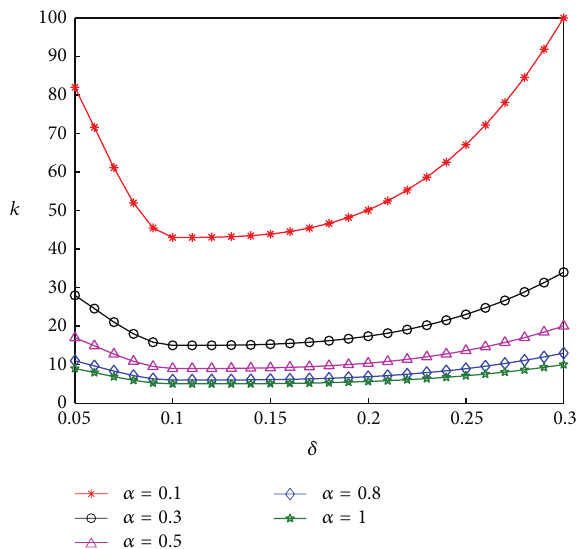
Figure 13: Correlation between 𝑘 and 𝛿 with given different 𝛼